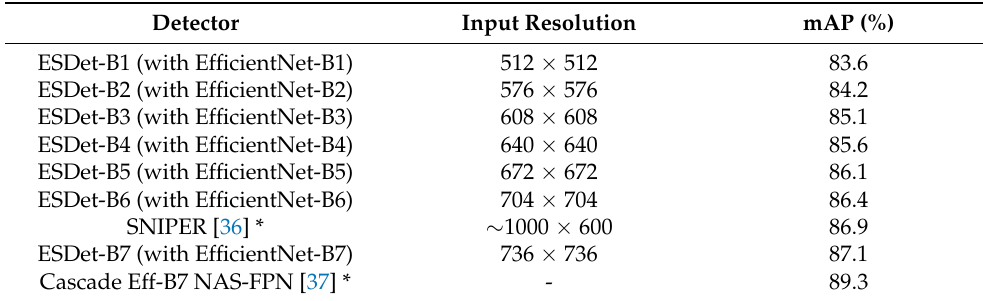
Table 7. Evaluation of results after extending it based on the ESDet-baseline. All evaluations were performed on the PASCAL VOC 07 test set. The (*) mark on the detector means a two-stage detector.